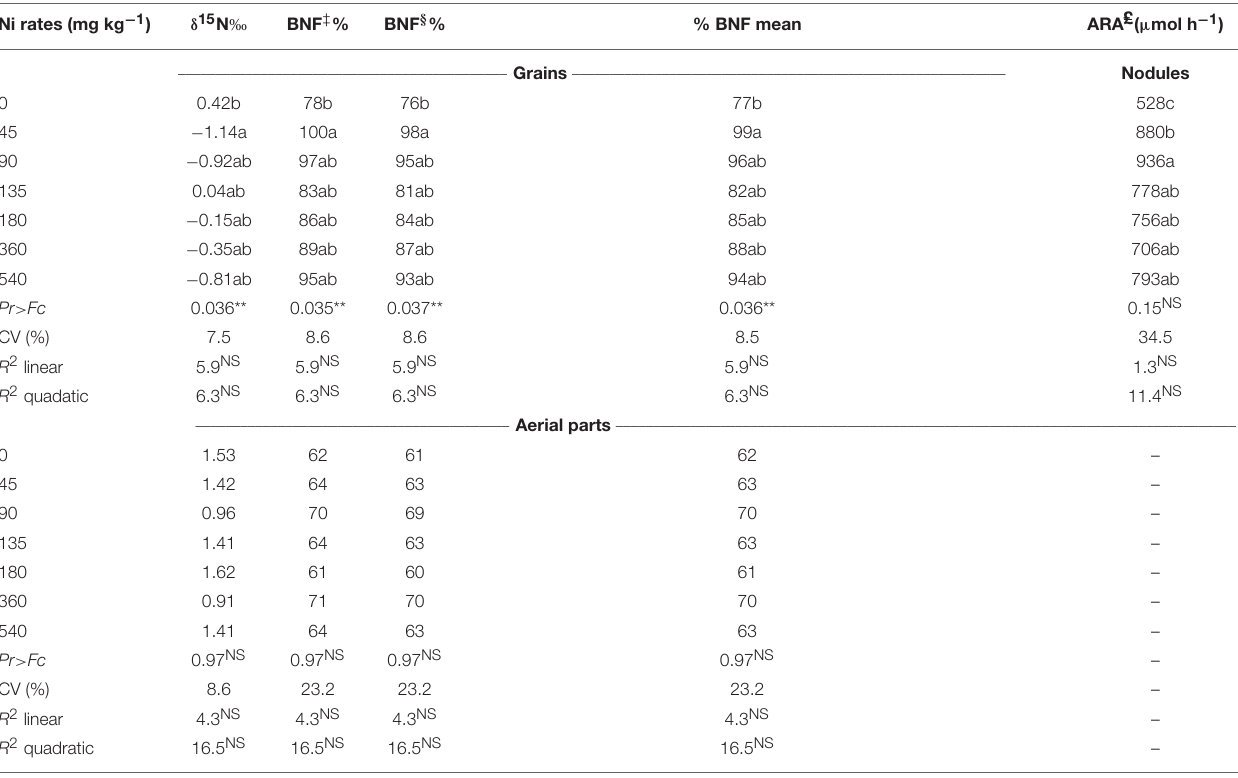
TABLE 3 | Natural abundance of 15 N ( δ 15 N ‰ ) and estimation of BNF (%) in the soybean plant (aerial parts and grain) and activity of reducing acetylene (ARA) in soybean nodules grown in greenhouse as related to the application of Ni rates via seed. Ni rates (mg kg − 1